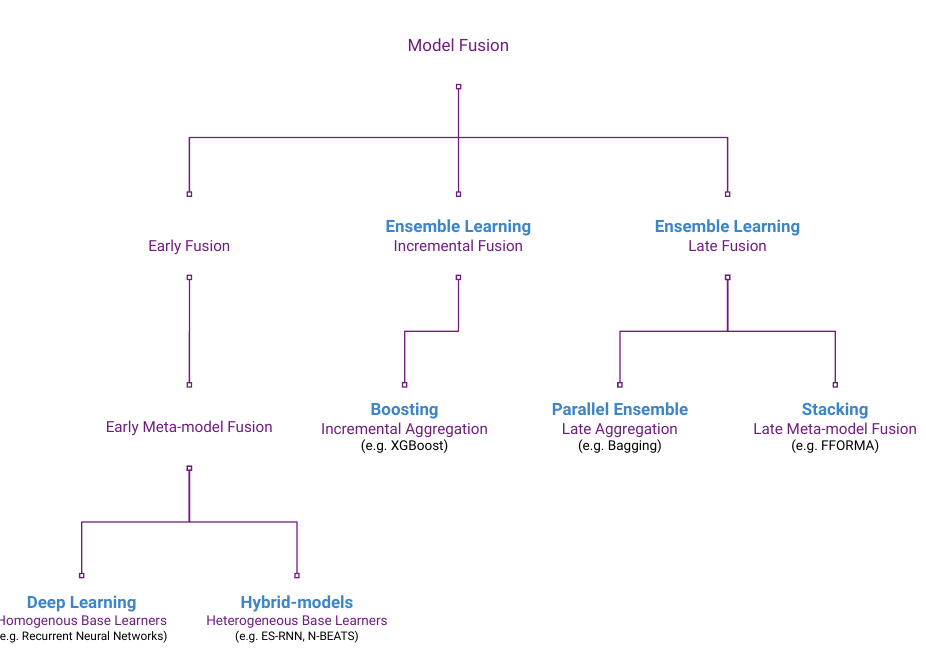
Figure 1. An incomplete taxonomy of model fusion showing ensemble learning, boosting, parallel ensembles, stacking, deep learning, and hybrid models